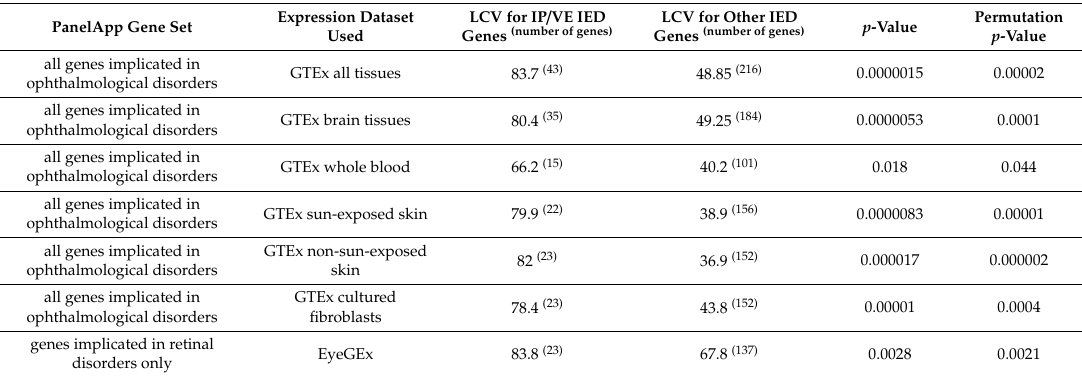
Table 1. Comparison of gene expression variability between genes that are possibly associated with variable penetrance and genes for which no evidence of variable penetrance was